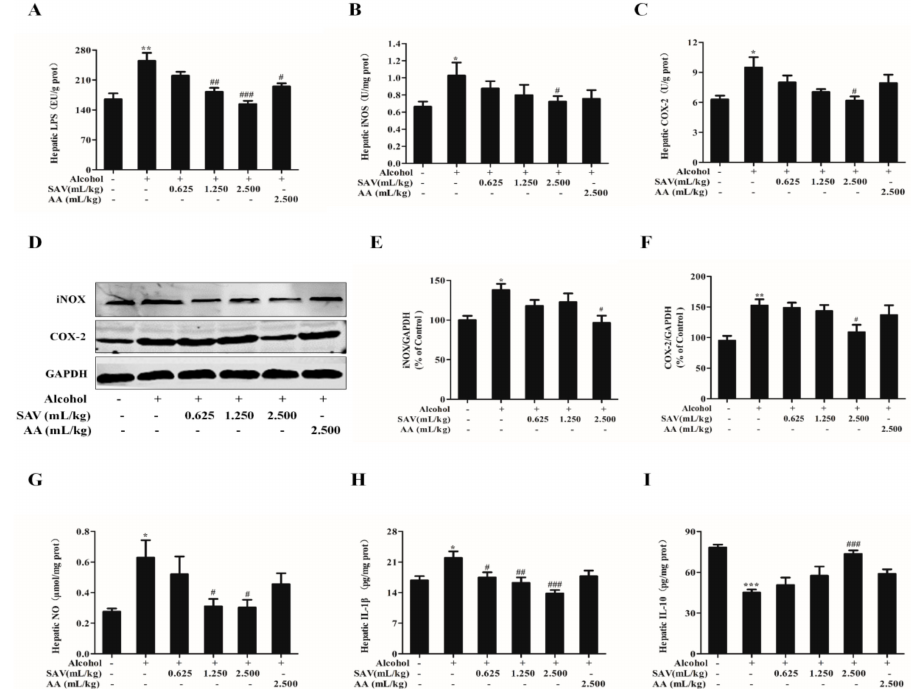
Figure 4. Effect of SAV on alcohol-induced inflammation. The level of LPS ( A ); the activities of iNOX ( B ) and COX-2 ( C ); ( D ) The expression levels of iNOX and COX-2; ( E ) Quantification of iNOX expression; ( F ) Quantification of COX-2 expression; ( G ) hepatic level of NO. the production of IL-1 β ( H ) and IL-10 ( I ) were determined with microplate reader. All data are expressed as mean ± SEM (n = 5–7). * p < 0.05 versus control group, ** p < 0.01 versus control group, *** p < 0.001 versus control group, # p < 0.05, ## p < 0.01, ### p < 0.001 versus ethanol